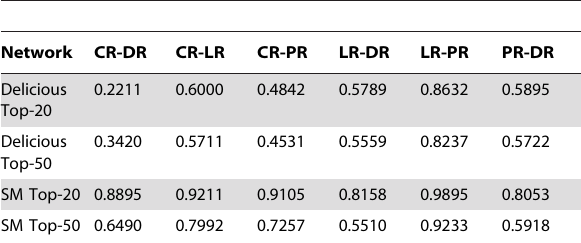
Table 3. Ranking correlation measured by Kendall’s tau between different